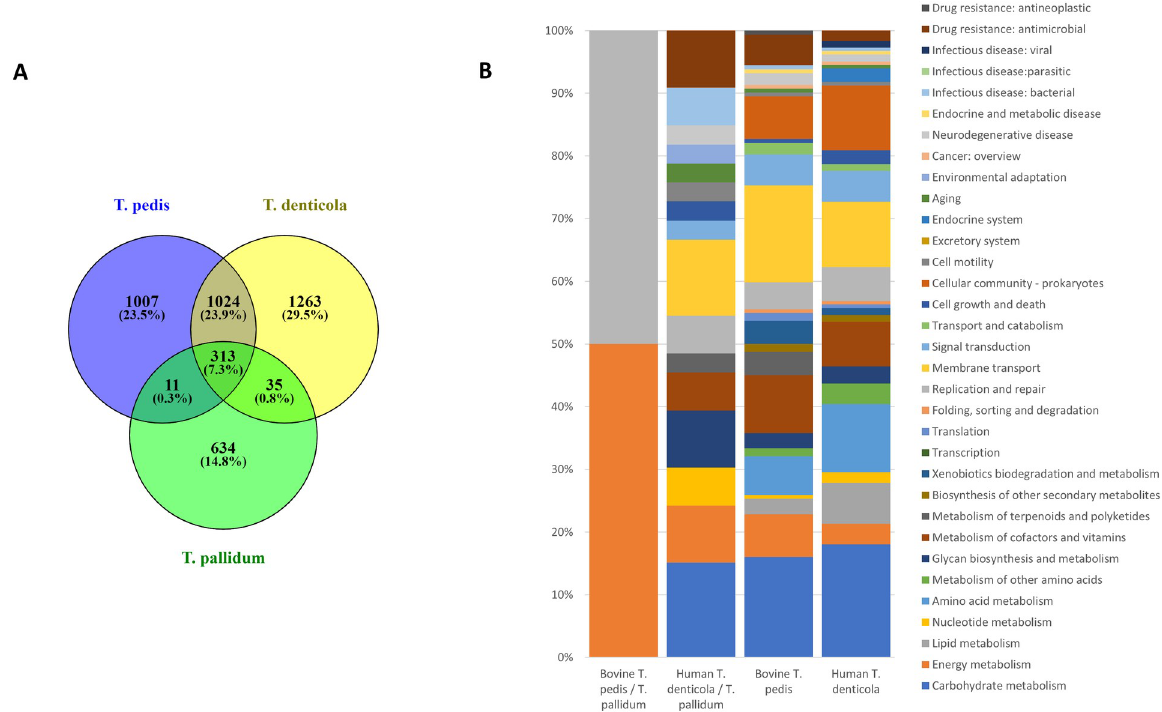
Fig 5. Core, accessory and unique genes shared between bovine pathogenic Treponema pedis and human pathogens Treponema denticola and Treponema pallidum . Venn diagram representation of the core, accessory and unique genes shared between bovine pathogenic T . pedis and human pathogens T . denticola and T . pallidum (A) . Numbers of shared gene families and/or unique genes are listed with the percentage of the total pan-genome this represents (for each comparison) listed in parentheses. Functional classification of genes unique to bovine pathogenic T . pedis and human pathogens T . denticola and T . pallidum or uniquely shared between either T . pallidum and either T . pedis or T . denticola ( B ). Only genes that could be assigned a KEGG category are represented in the bar graphs. Only 269 entries (26.7%) of the 1007 unique genes from bovine T . pedis could be annotated, only 318 entries (25.2%) of 1263 unique T . denticola genes could be annotated.: Only 8 entries (72.7%) annotated of the 11 uniquely shared genes between T . pallidum / bovine T . pedis could be annotated, only 28 entries (80.0%) annotated of 35 uniquely shared genes between T . denticola / T . pallidum could be